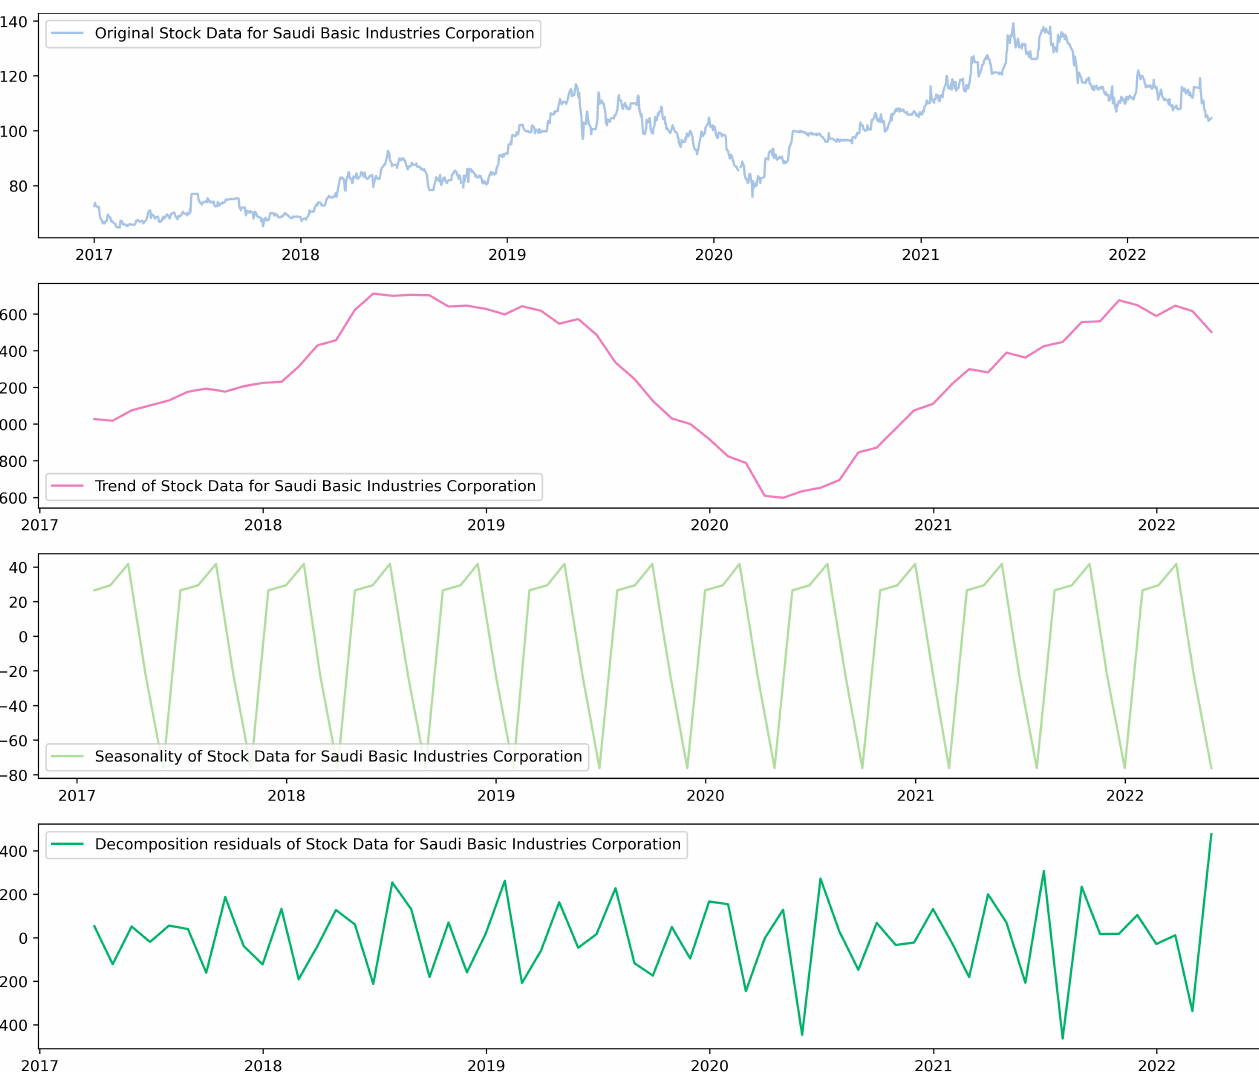
Figure 12. Decomposition of 2010 Stock Data: Trend, Seasonal (Periodic), and Residual